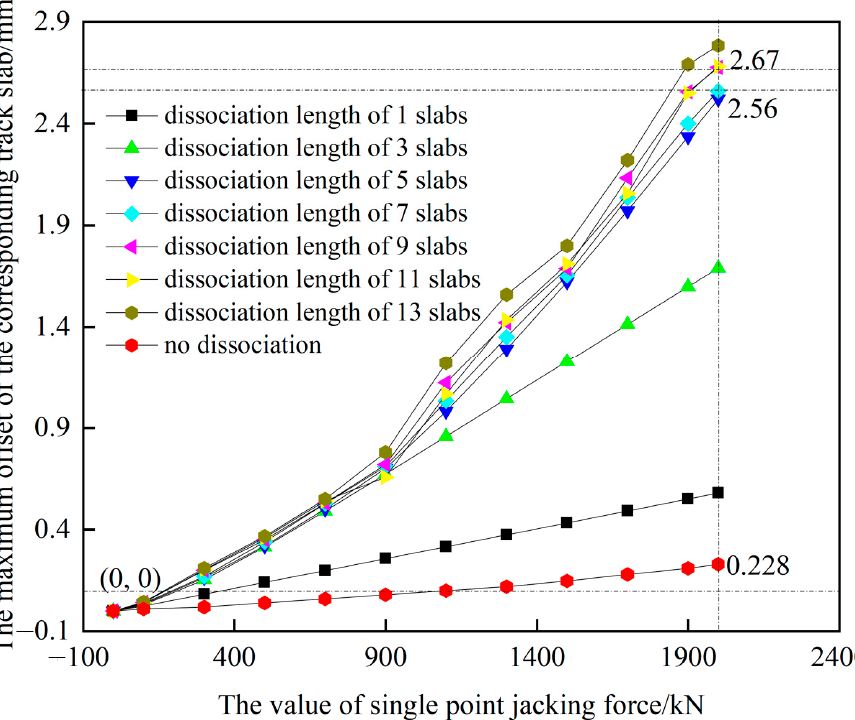
Figure 4. Effect of dissociation length on single point jacking rectification.